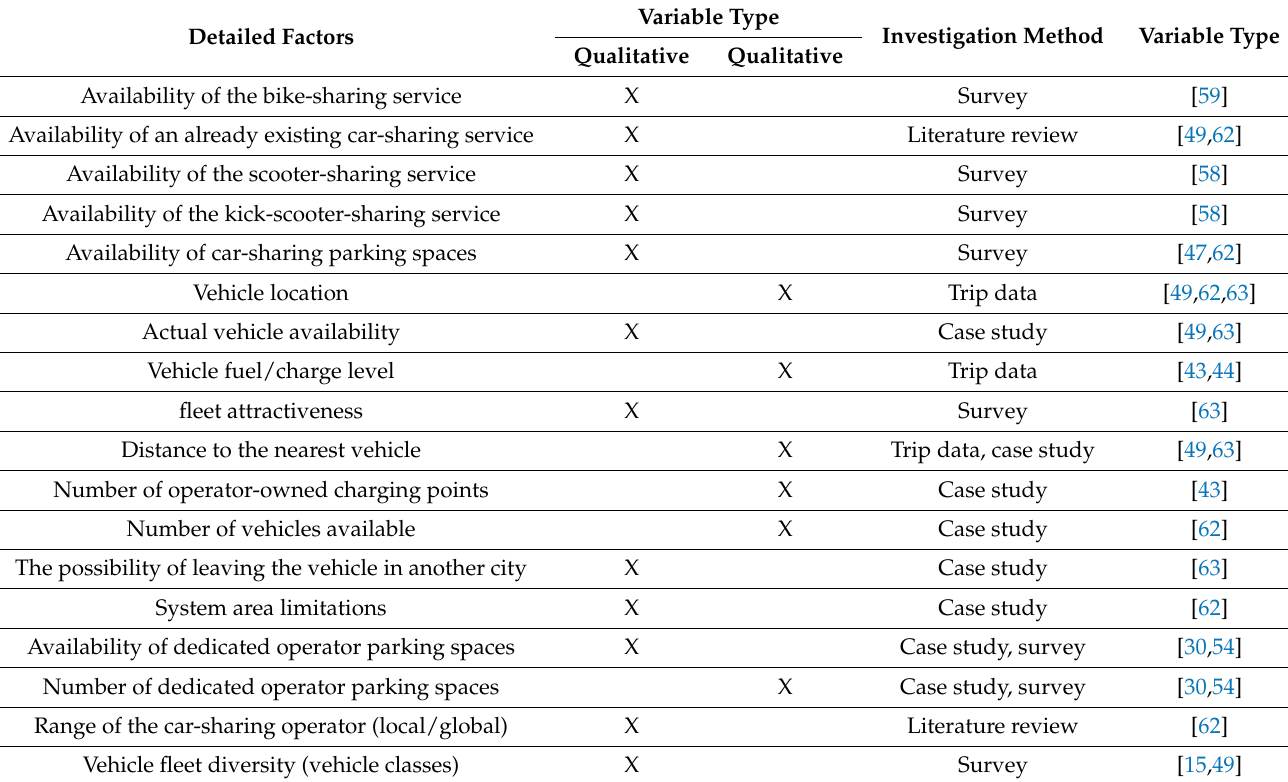
Table 6. Factors related to shared